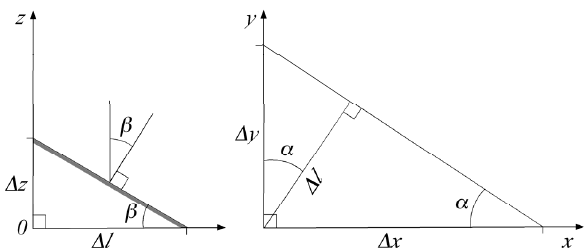
Fig. 1. Left: Vertical section in the steepest direction of the sloping surface. The grey line indicates the surface. Right: Projection of the sloping surface into the horizontal x − y plane at z =0.